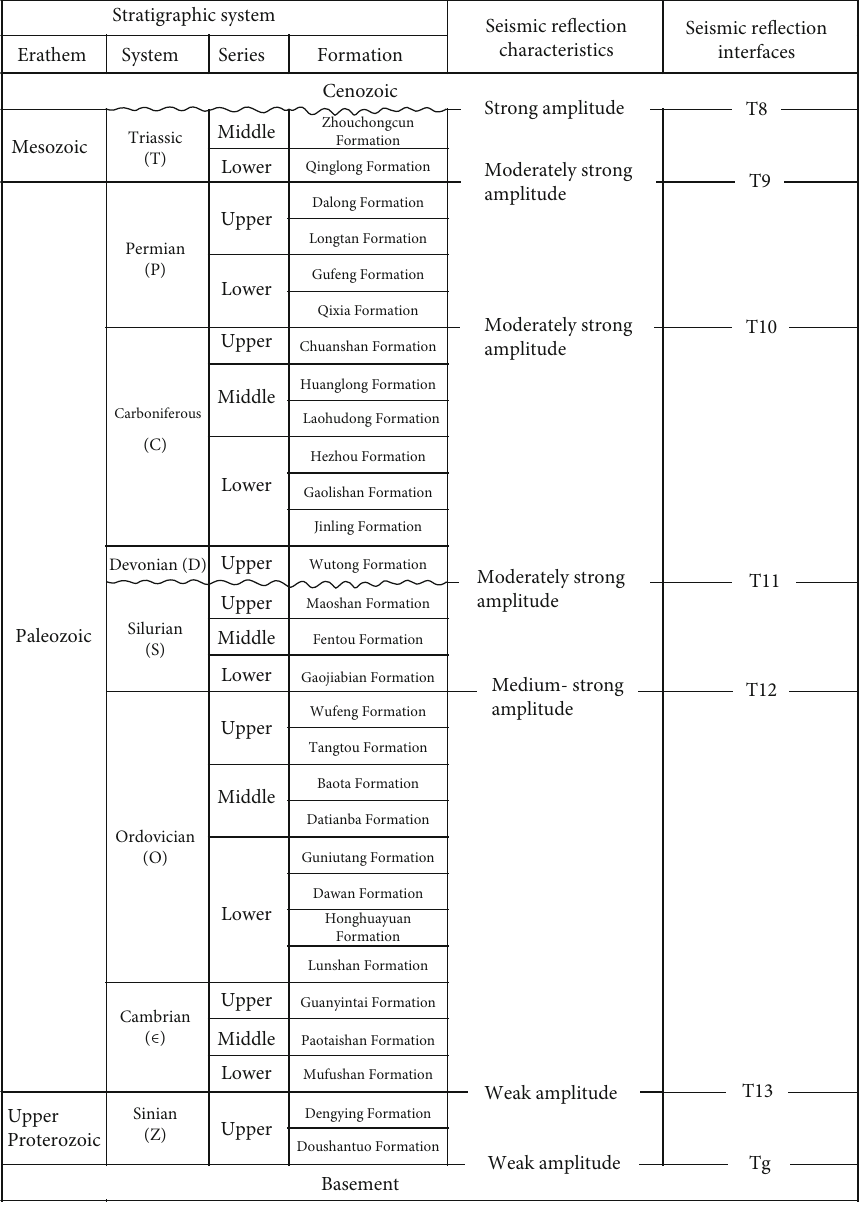
Figure 2: Comparison of strata and seismic re fl ection characteristics of the Wunansha Uplift in the South Yellow Sea